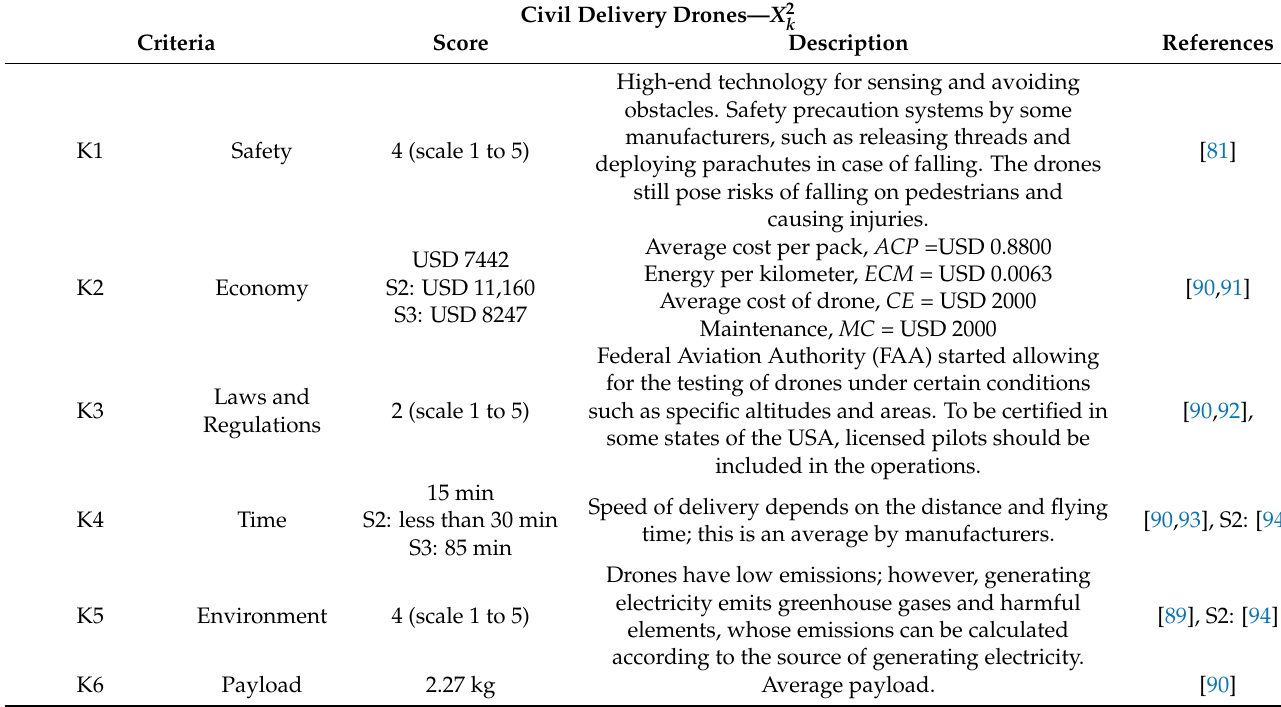
Table 3. Civil drone scores in the case of S1 (unless otherwise mentioned).